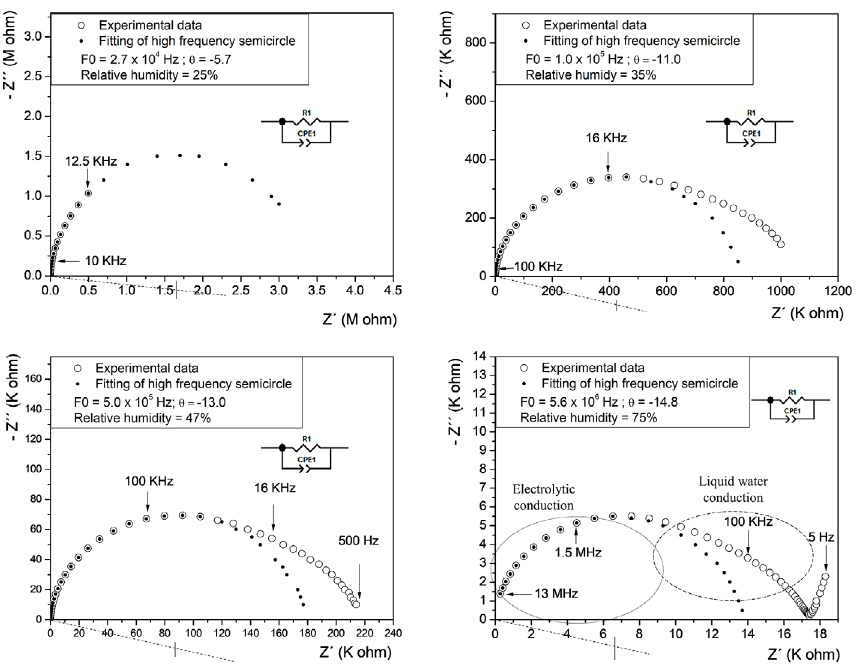
Figure 10. Equivalent circuits and Nyquist plots at room temperature of composition B sintered at 1350ºC with varying relative humidity